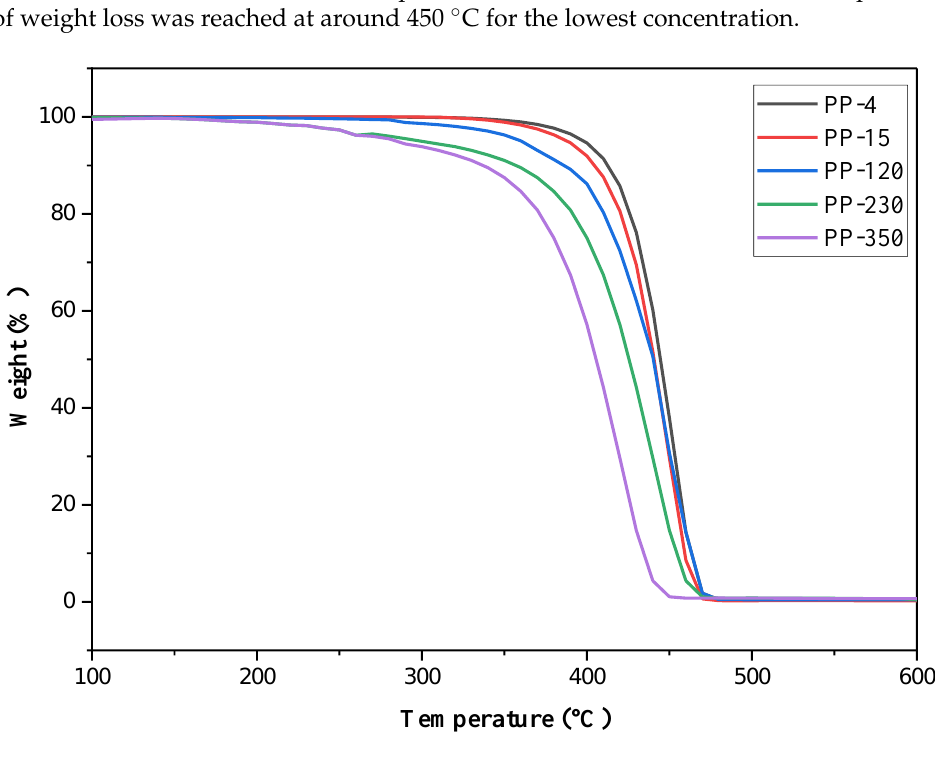
Figure 2. The thermogravimetric analysis of the PP samples.